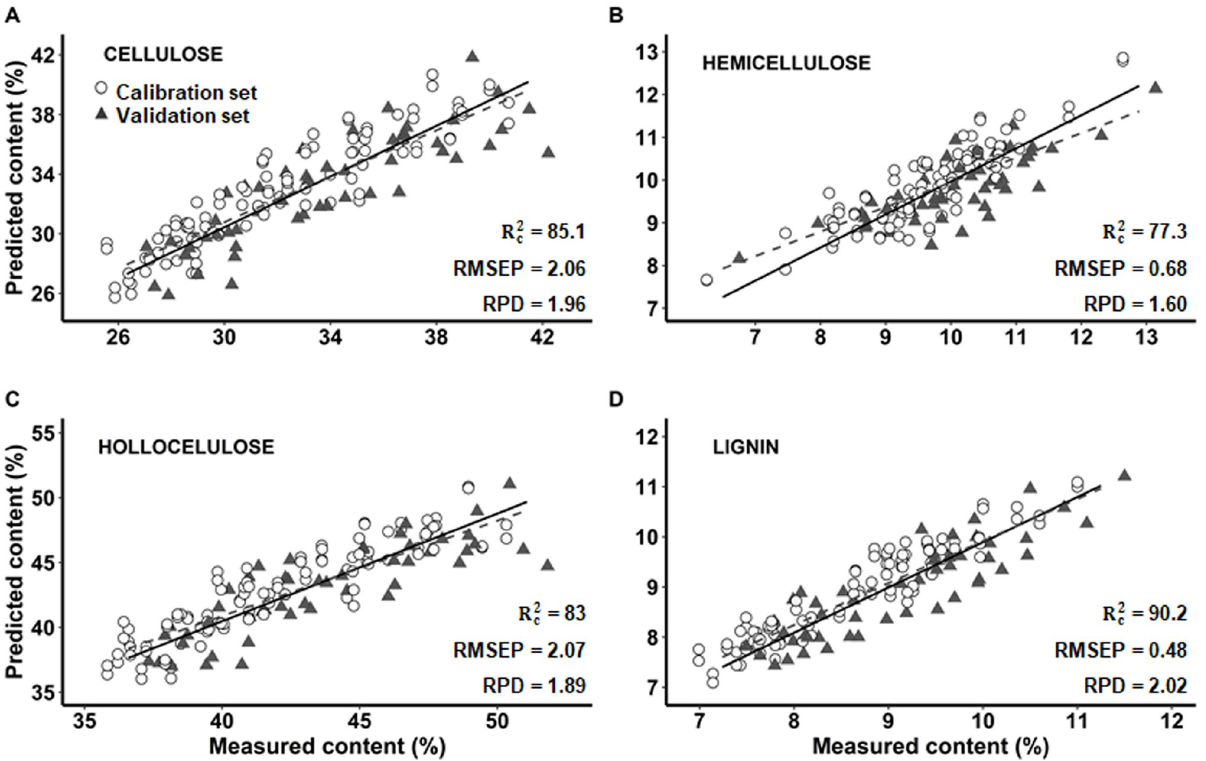
Fig 2. Prediction of cellulose, hemicellulose, hollocelulose and lignin content by multivariate models with FT-IR (PLS) in Capirona ( C . spruceanum) . A: Cellulose, B: Hemicellulose, C: Holocellulose and D: Lignin. R 2 squared error of predictions. RPD: ratio of performance to deviation. Solid line: regression line of calibration set. Dashed line: regression line of validation